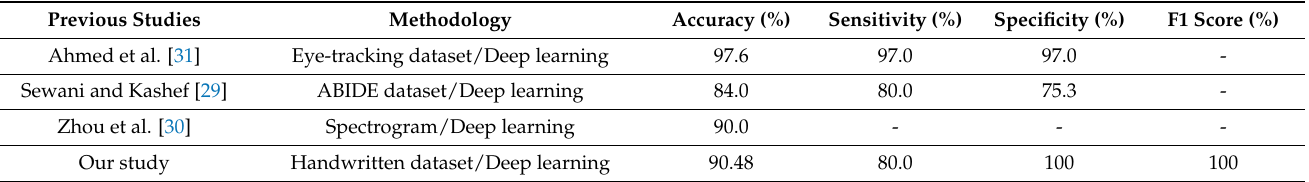
Table 3. Comparison of results with previous